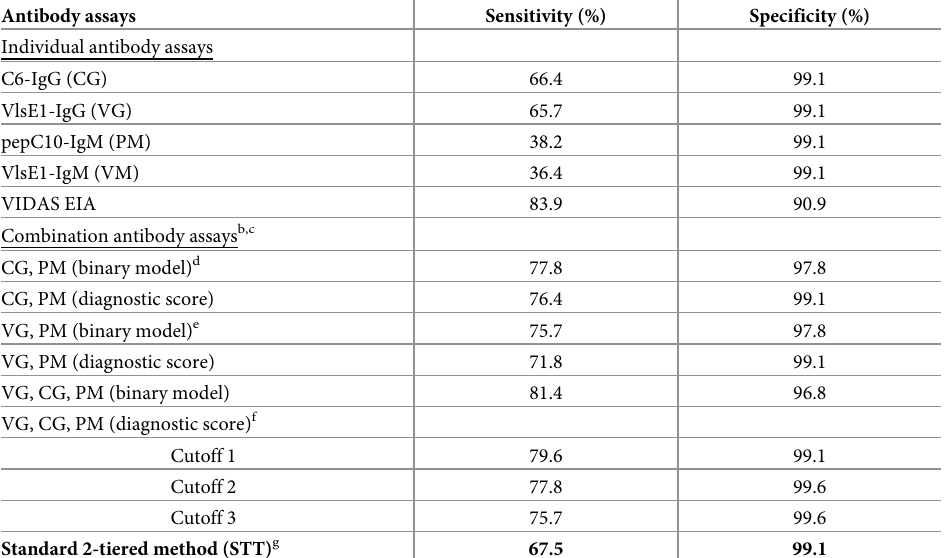
Table 3. Sensitivity and specificity of antibody response to recombinant and peptide antigens in 280 patients with Lyme disease and 559 controls a